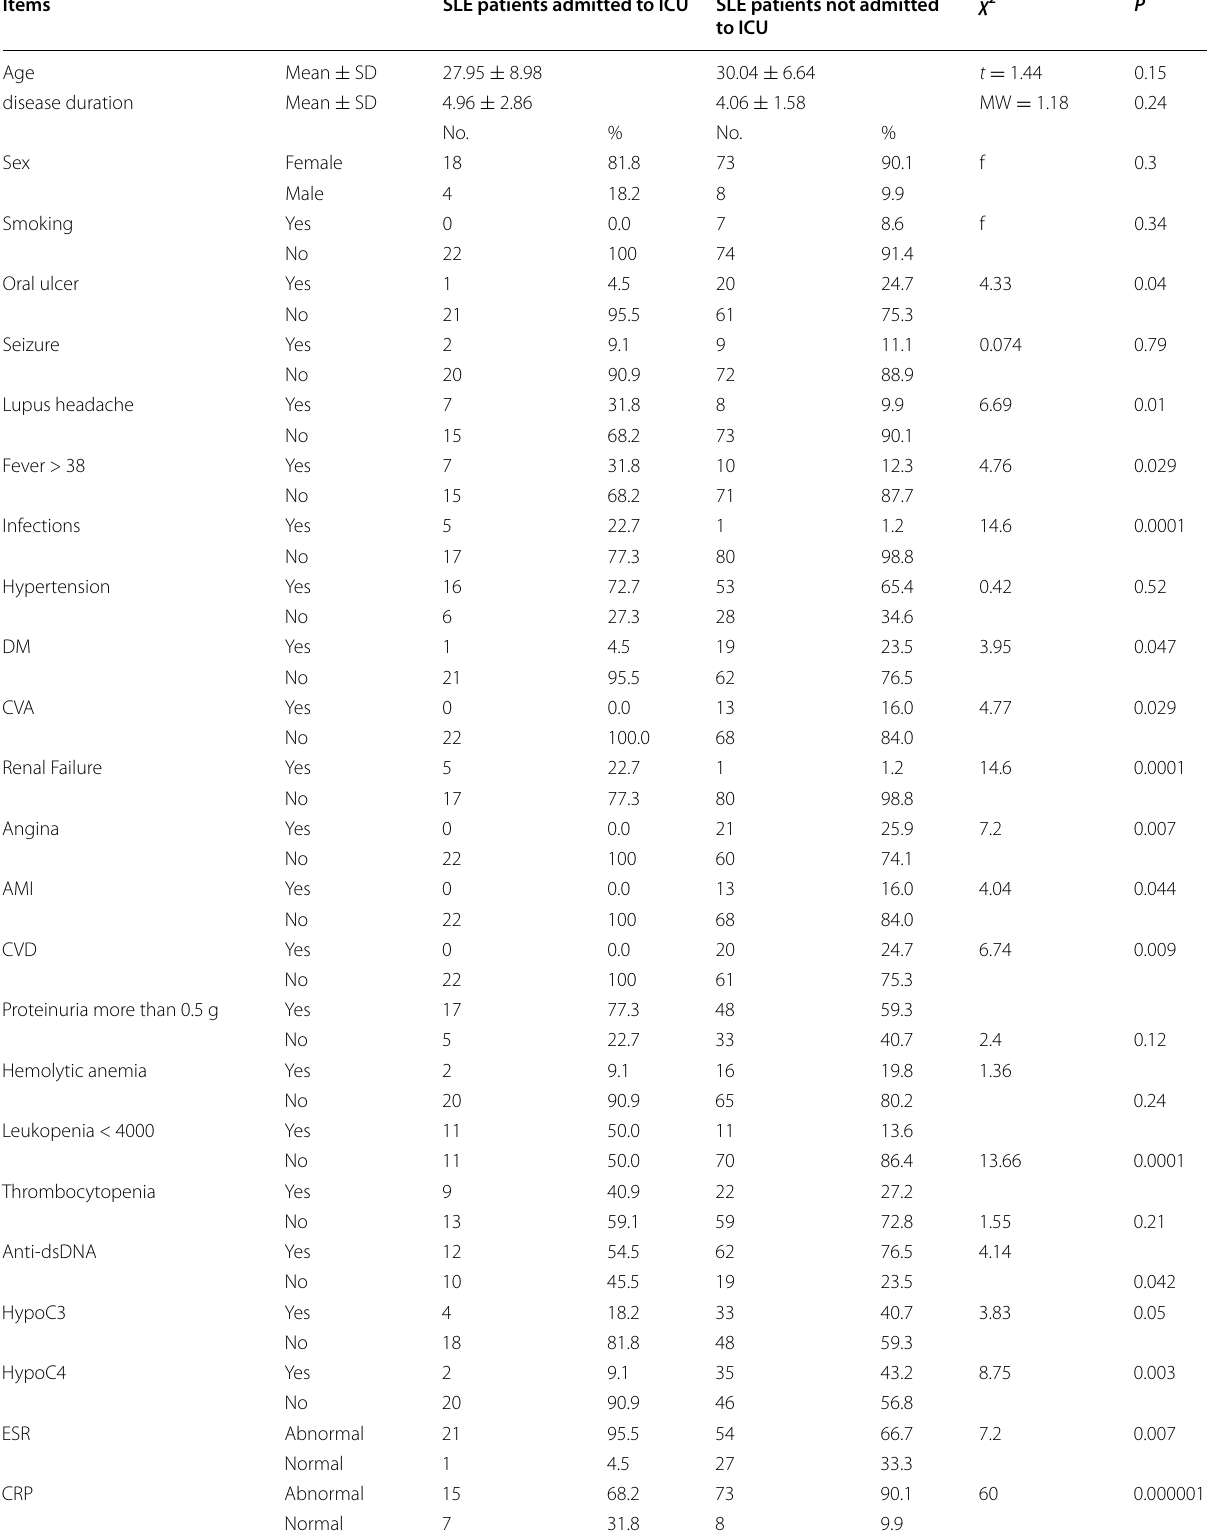
Table 2 Comparison of clinical finding and type of treatment of SLE patients admitted to ICU and others during 1‑year